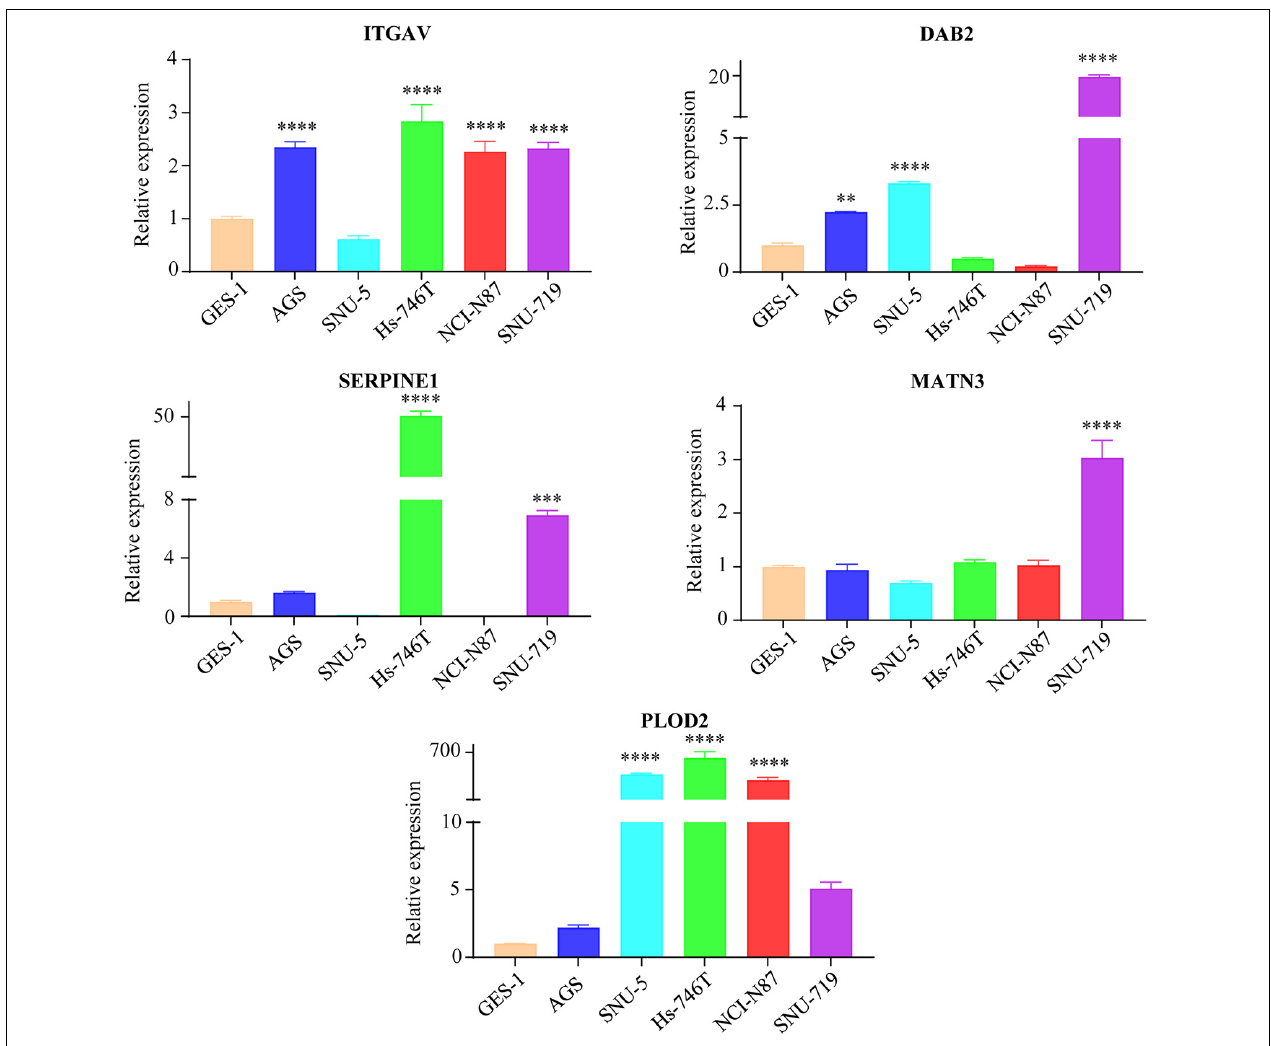
FIGURE 6 | The mRNA expression levels of EMT-related genes (ITGAV, DAB2, SERPINE1, MATN3, and PLOD2) in GC cell lines and normal gastric mucosal cell line GES-1 detected by qRT-PCR. The gastric mucosa epithelial cell line GES-1 was used as control. ∗∗ p < 0.01, ∗∗∗ p < 0.001, and ∗∗∗∗ p <